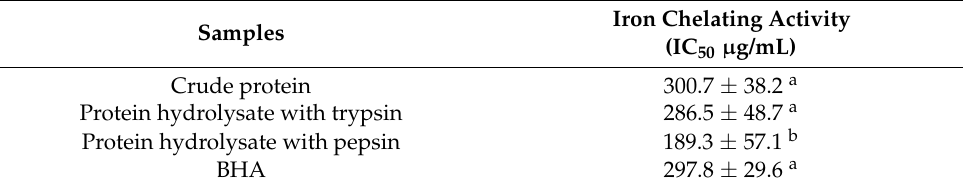
Table 2. Iron chelating activity of protein hydrolysates from S. ricini